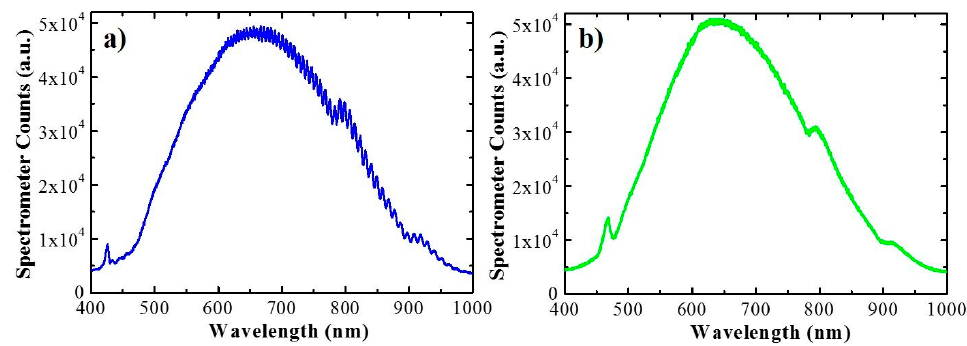
Figure 6. Signal measured by the fiber spectrometer for the short sample ( a ) and long sample ( b ) placed in the flow cell respectively. ( b ) placed in the flow cell